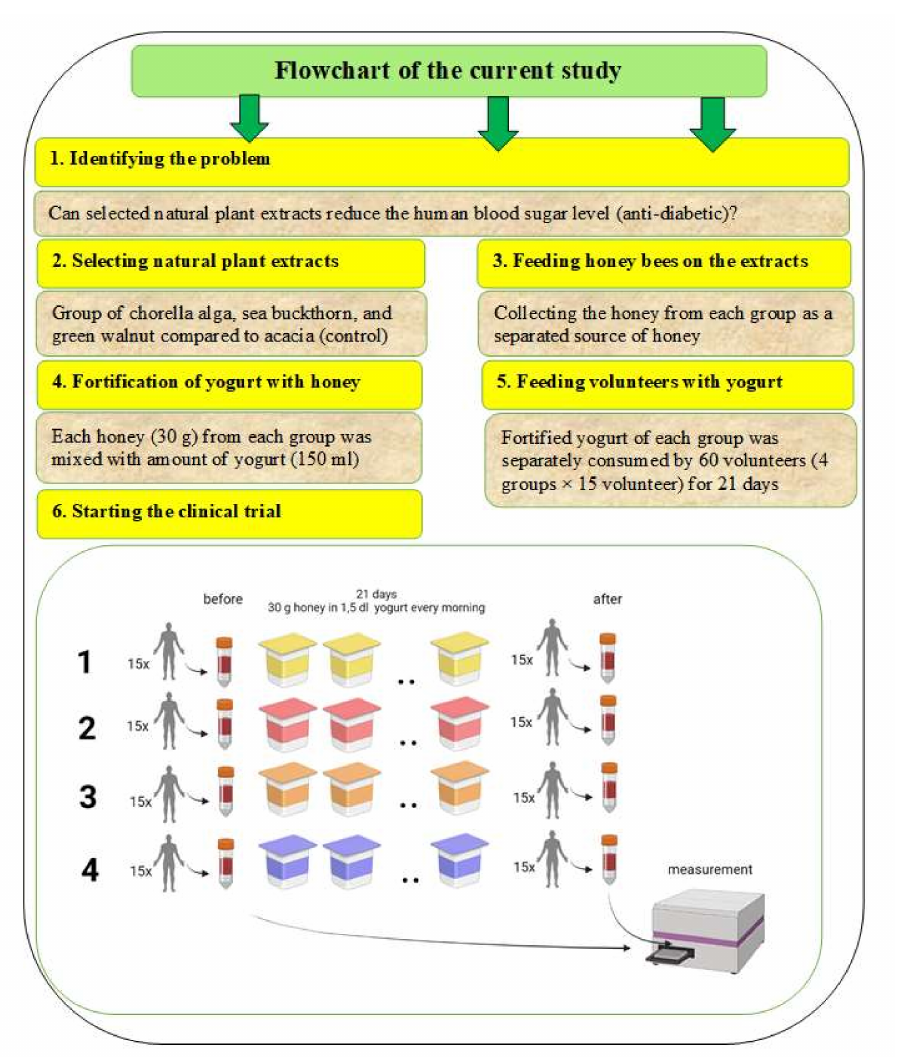
Figure 7. The main steps already carried out during this study include the clinical trial. The tested honey products were consumed in yogurt. The treatment: (1) acacia honey (as a control), (2) chlorella alga honey, (3) sea buckthorn honey, and (4) green walnut honey. In total, 30 g of honey product was added to 150 mL of yogurt. The volunteers consumed only one yogurt-honey box every day for 21 days and blood samples were taken before and after the yogurt consumption during the clinical trial. Very important note: Some volunteers were excluded from the study as follows: for the first, second, and third groups, one, three, and one volunteer, respectively. One had a high initial blood sugar level, and the others gave up participation in the trial, whereas, in the fourth group, all of the participants took part from the beginning until the